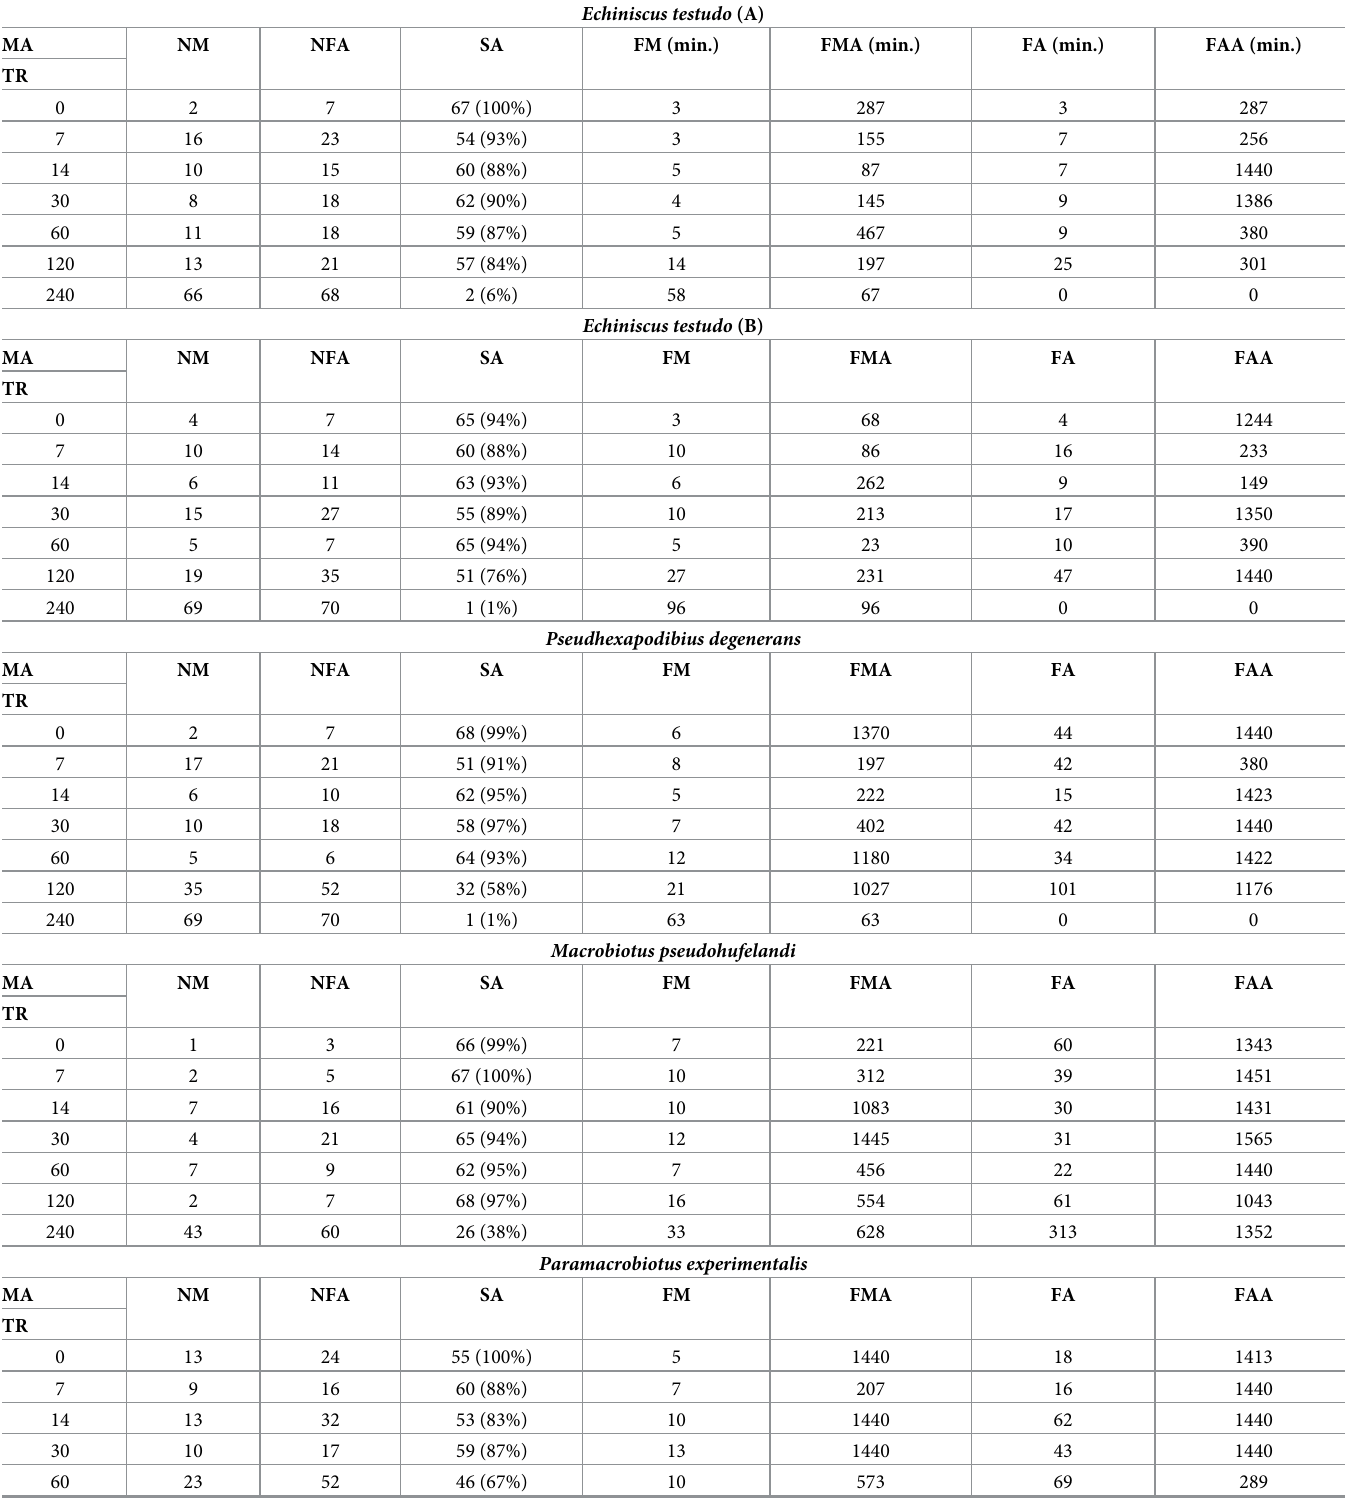
Table 2. Values of applied measures of survival and activity used to estimate anhydrobiosis